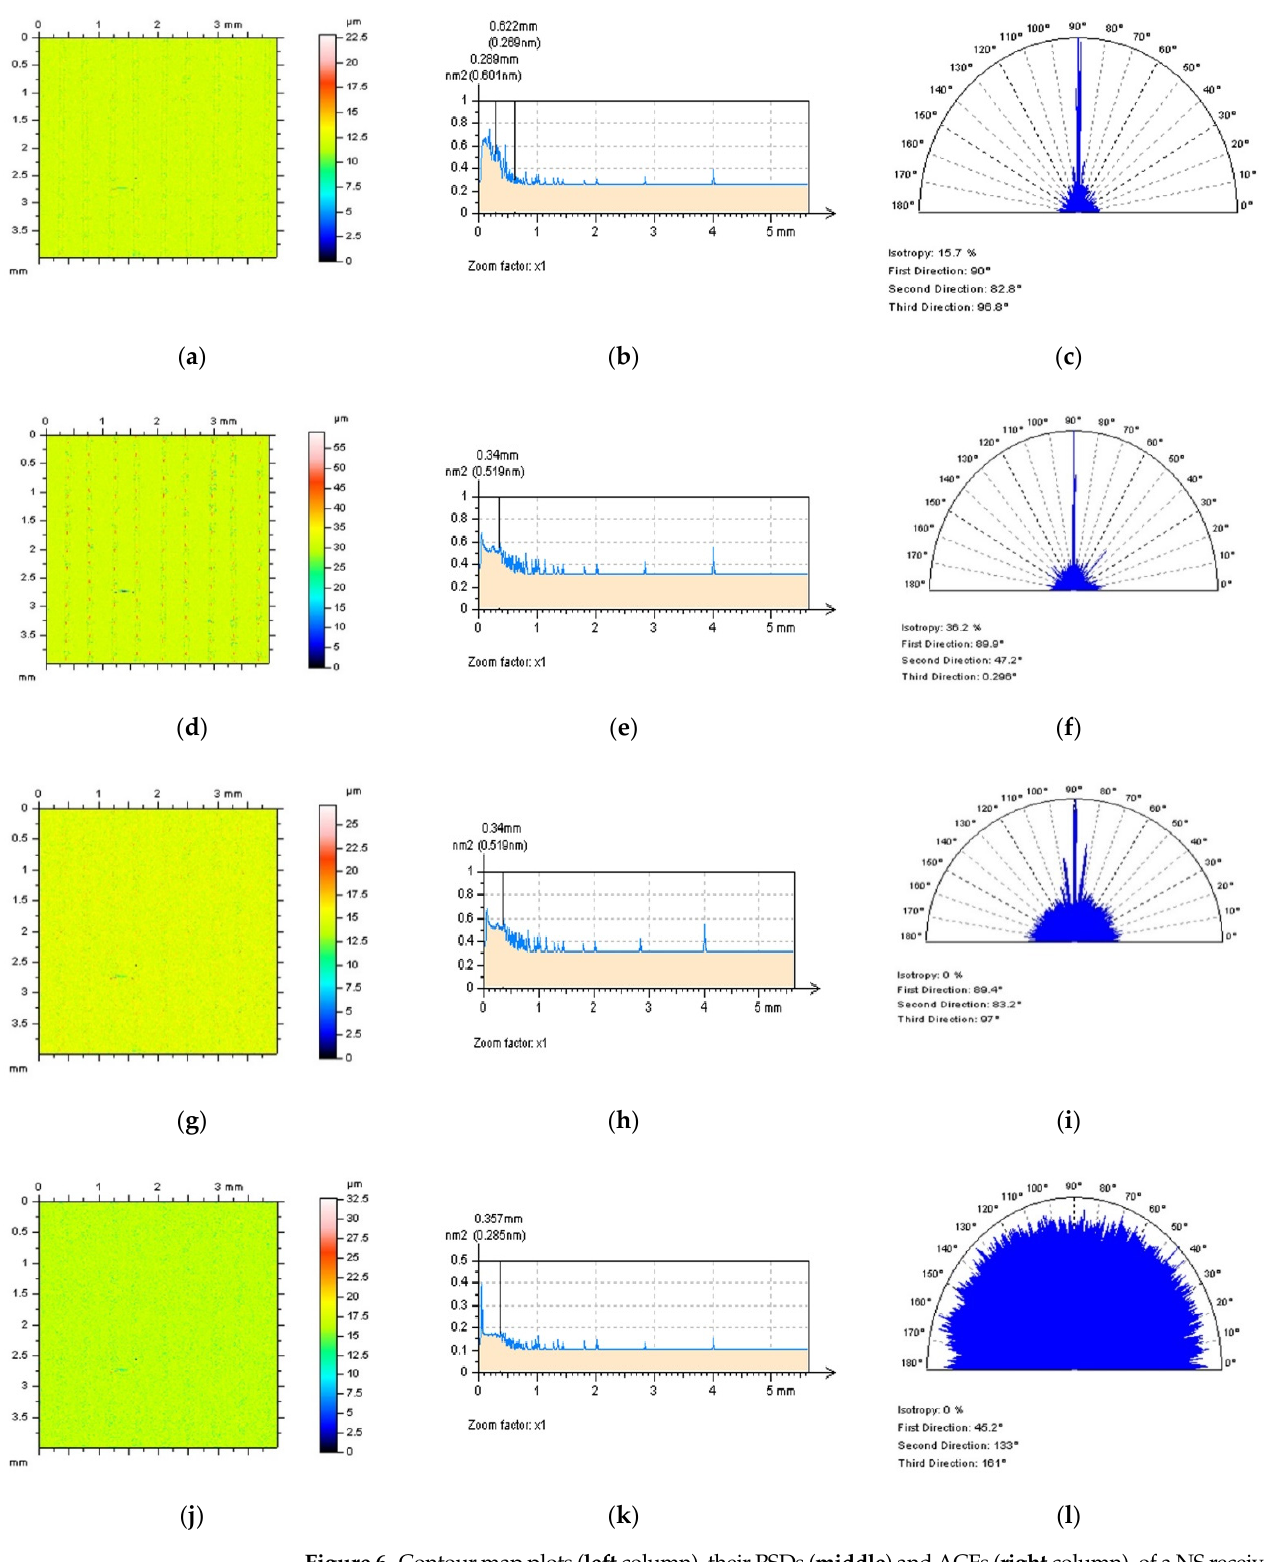
Figure 6. Contour map plots ( left column), their PSDs ( middle ) and ACFs ( right column), of a NS received by application of GF ( a – c ), RGF ( d – f ), SF ( g – i ) and FFTF ( j – l ) method with the cutoff = 0.025 mm.